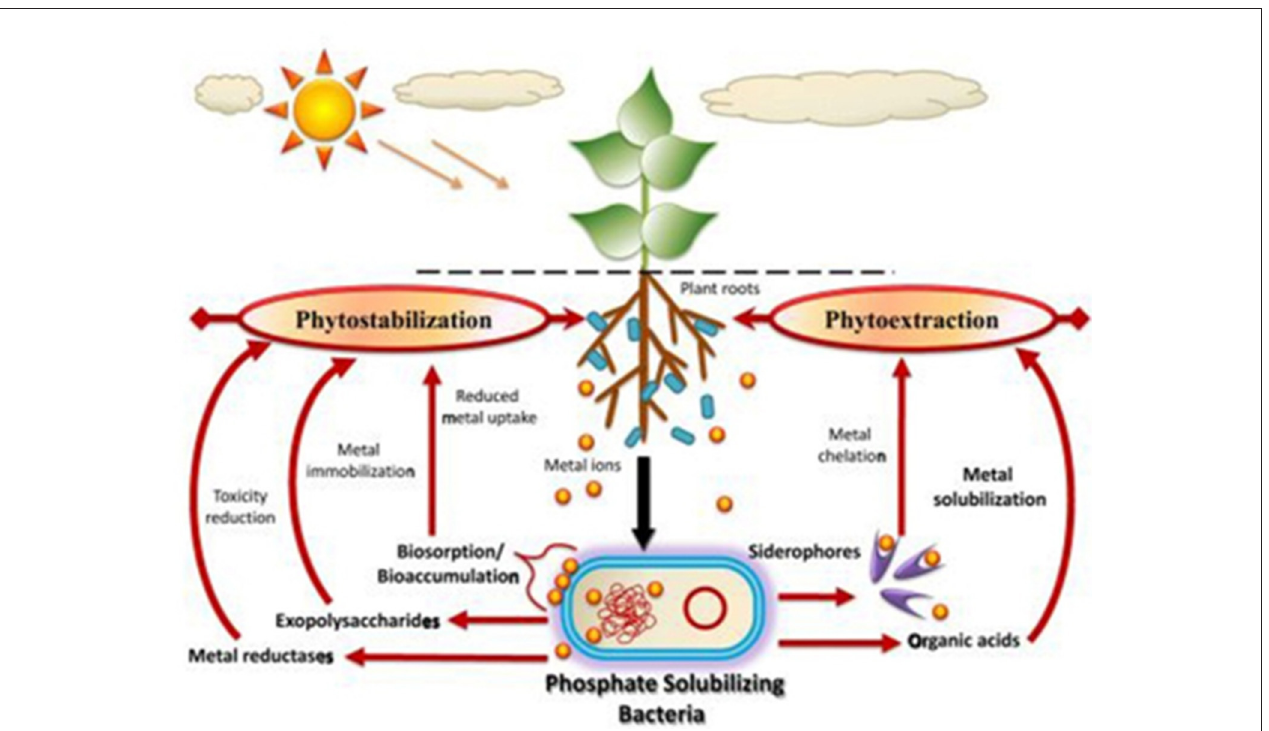
FIGURE 5 | Various microbial interaction with heavy metals (Source: Ahemad, 2015) Copyright 2018, Springer Nature.